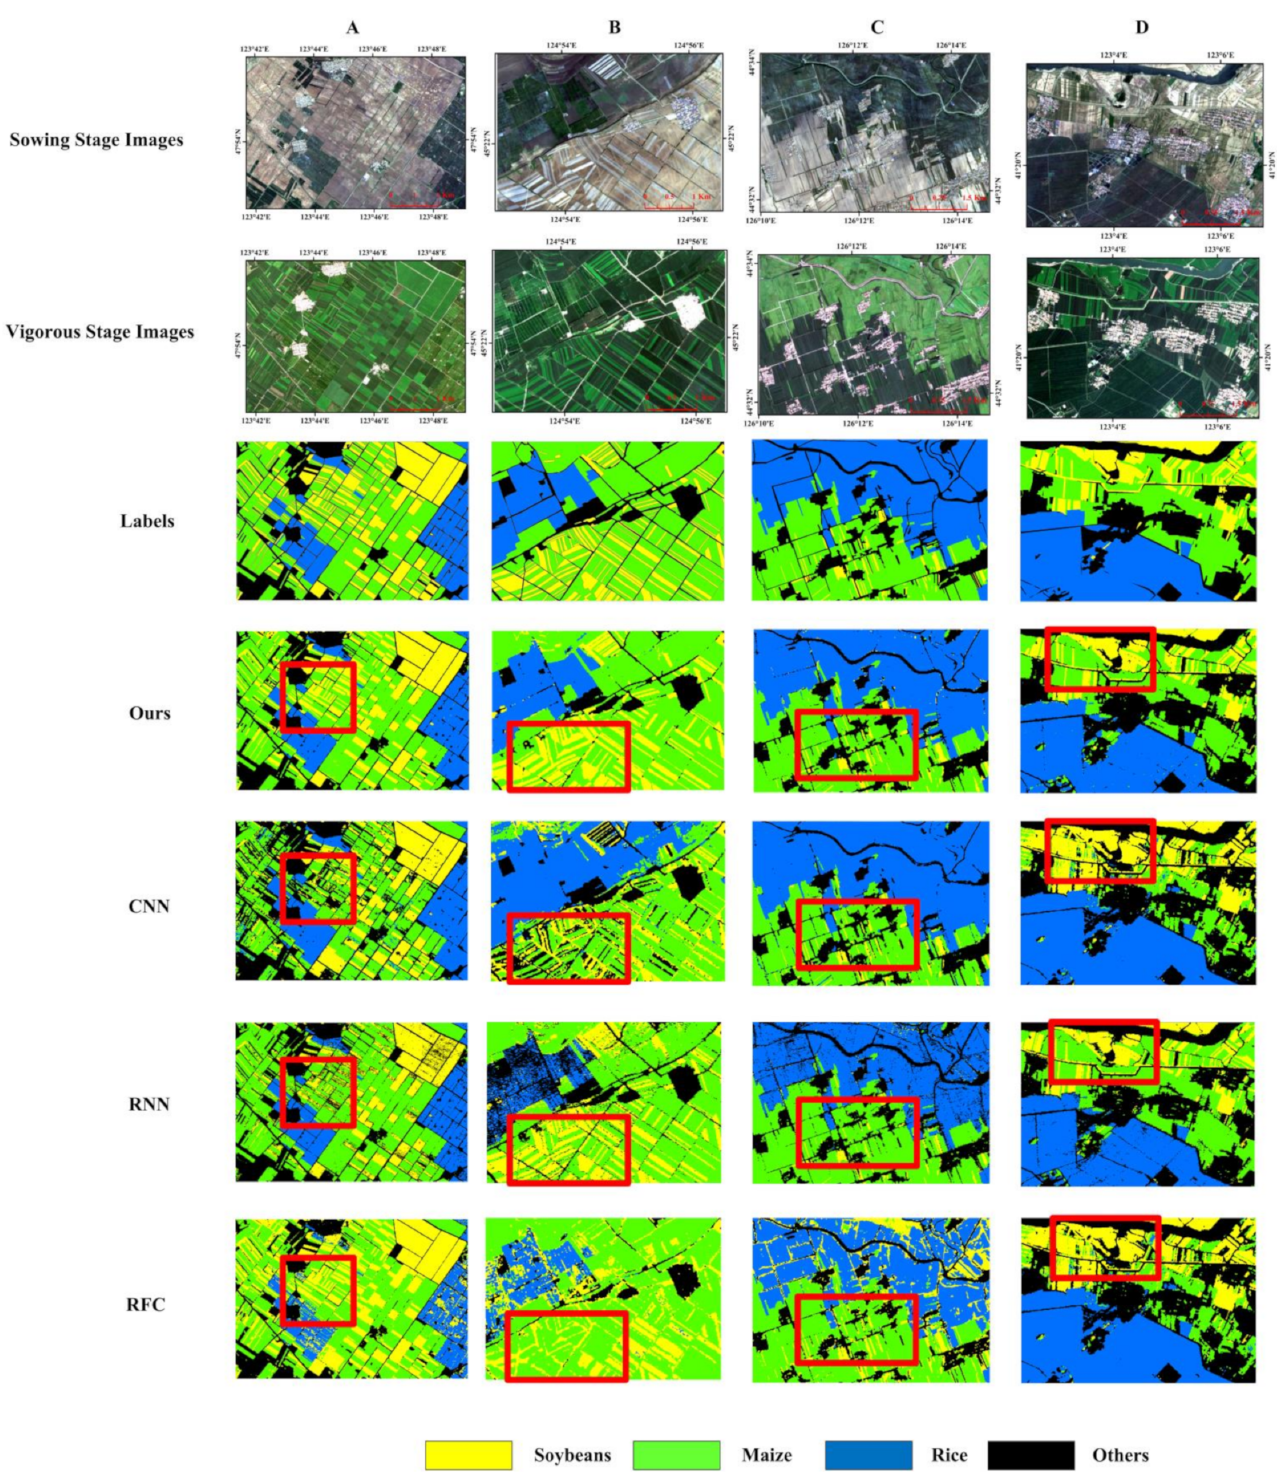
Figure 8. ( A – D ) Input images of four test areas and test results of different models. The red wireframe shows the difference in